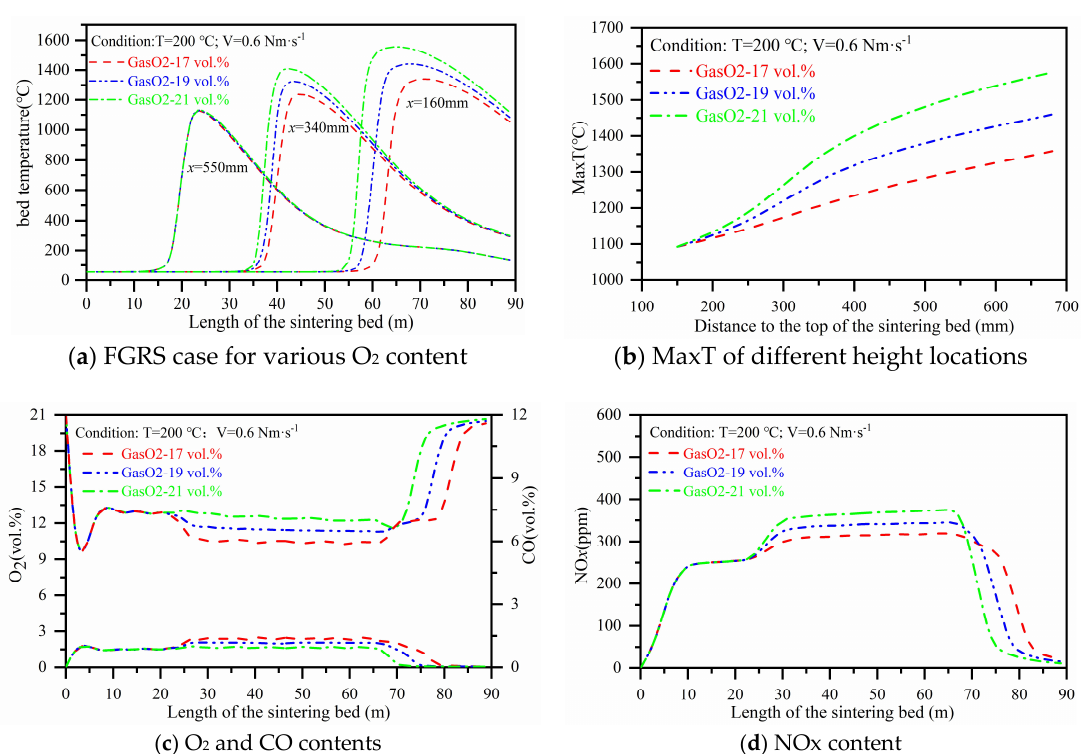
Figure 6. E ff ects of circulating gas O 2 content on the NOx, CO and O 2 contents in flue gas and layer